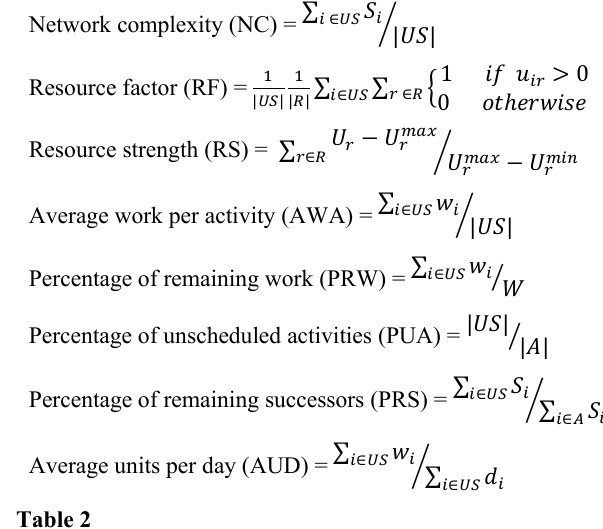
The definitions of employed elements in the formulas’ parameters